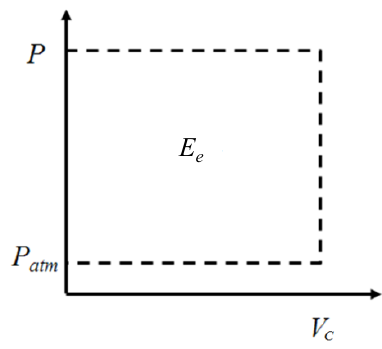
Figure 5. The ideal P-V diagram of constant pressure